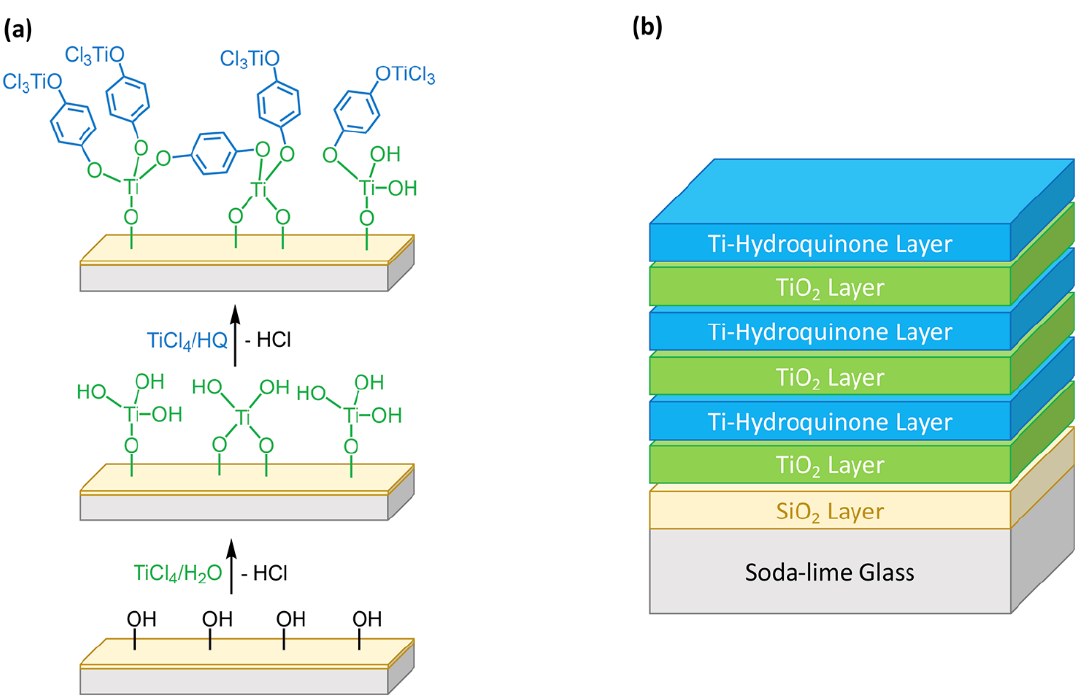
Figure 3. Schematic representation for the deposition of inorganic-organic thin films on glass com- posed of TiO 2 layers (prepared by TiCl 4 /H 2 O ALD) and hybrid Ti/HQ layers (prepared by TiCl 4 /HQ MLD): ( a ) sequential deposition of single cycle ALD/MLD layers; ( b ) sequential deposition of TiO 2 and Ti-HQ layers generated by multiple ALD and MLD cycles, respectively [58].